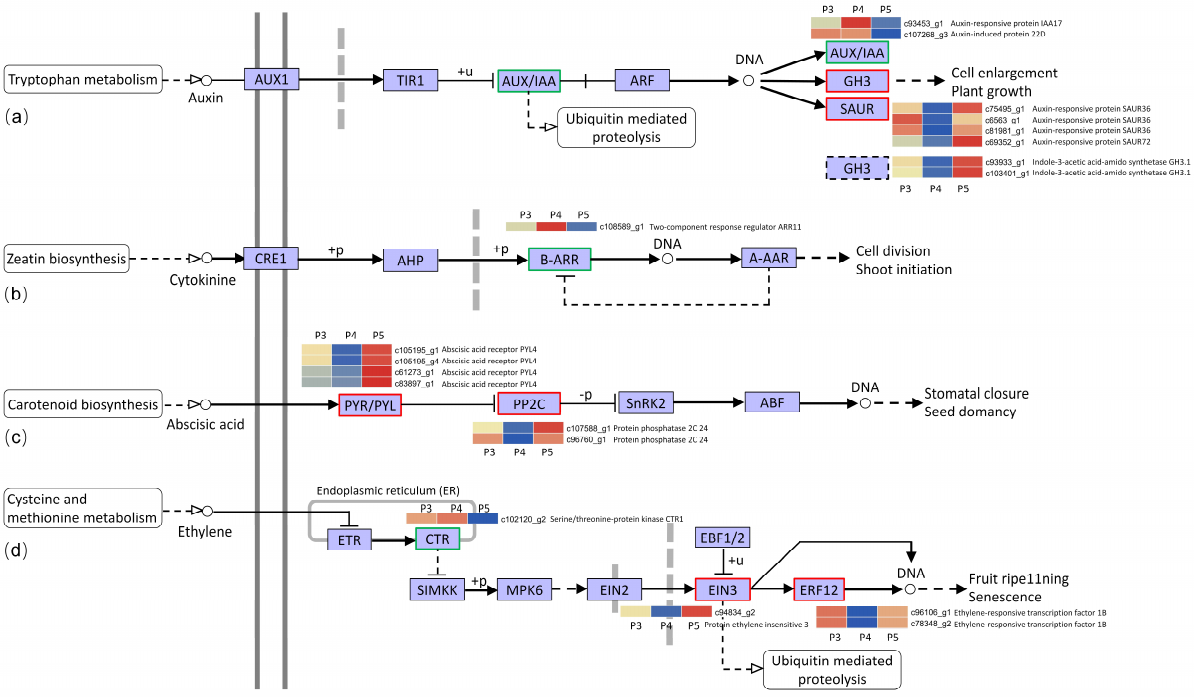
Figure 5. Enriched KEGG pathway terms associated with plant hormone signal transduction in P4 vs. P5. ( a – d ) The auxin, cytokinin, abscisic acid, and ethylene signal transduction pathways. The borders of KO nodes of upregulated genes are marked in red, and the downregulated genes are marked in green. The expression level of the related unigenes from P3 to P5 are shown in the heatmap beside the nodes, the color from blue to red means that the gene expression level is from low to